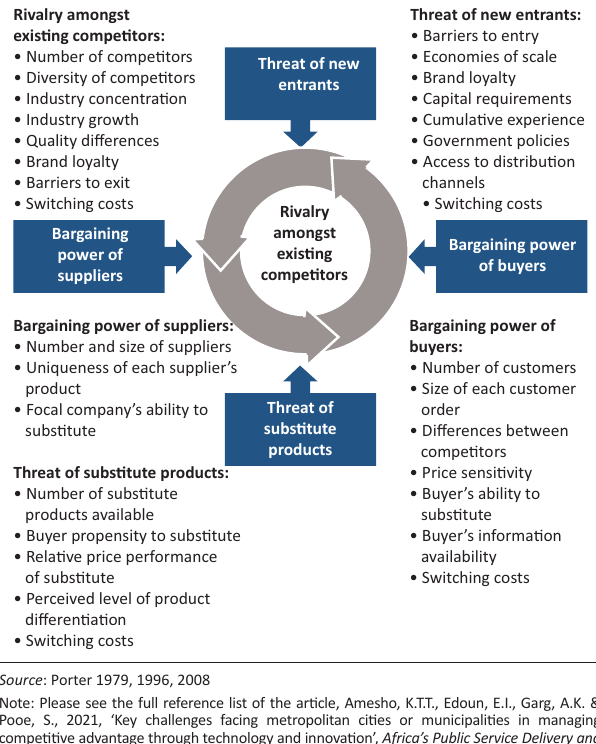
FIGURE 2: Porter’s Five Forces